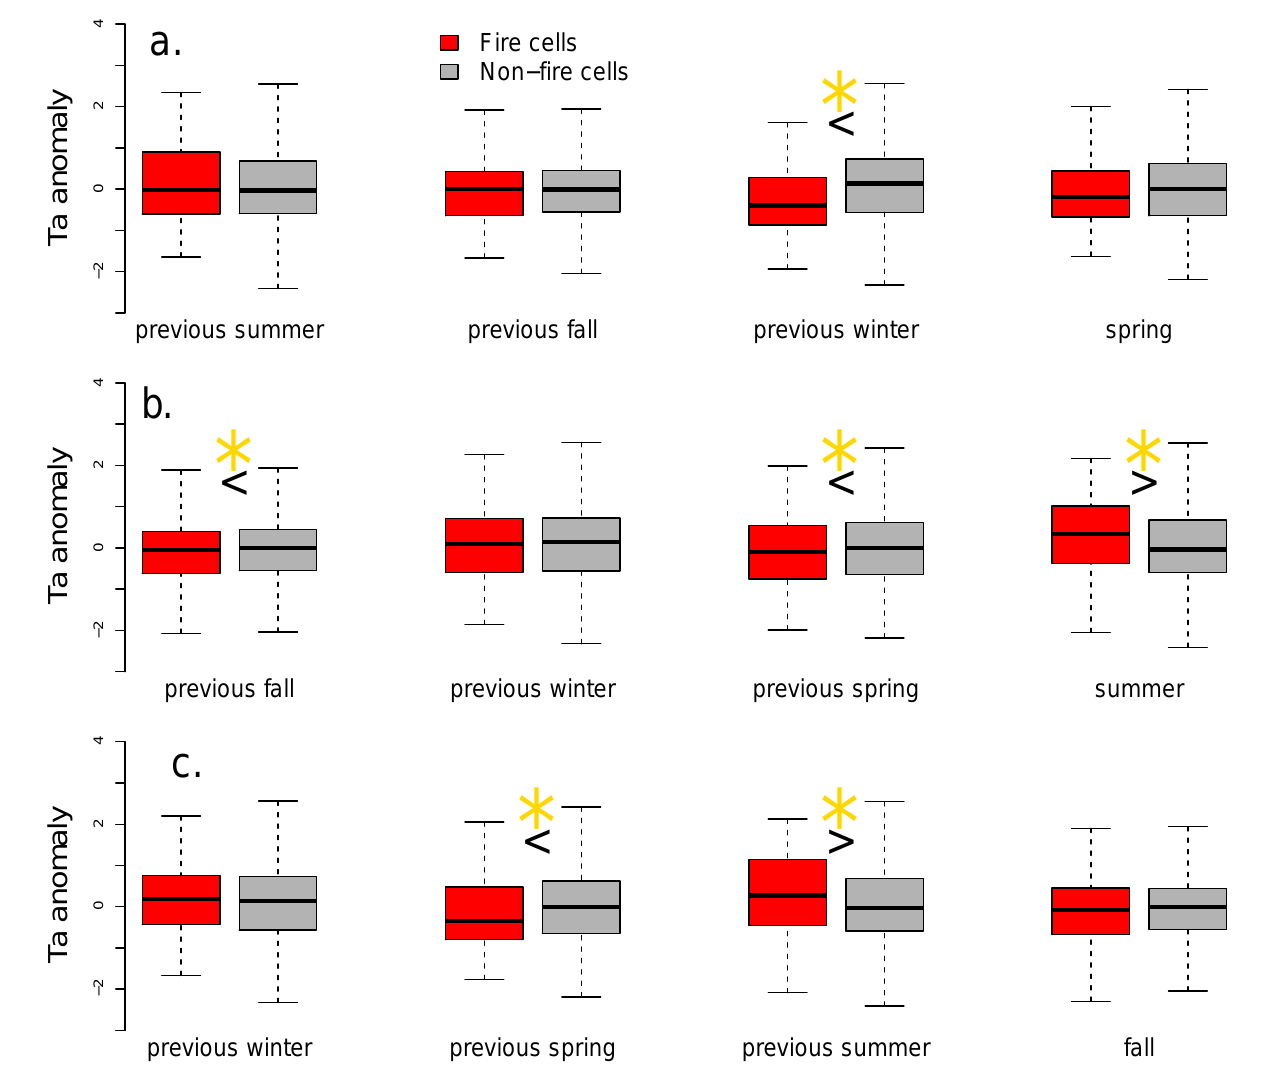
Figure 4. Boxplots illustrating differences in the anomaly of high-air-temperature months (anomaly = observed − long-term mean/standard deviation of long-term mean) between ignition (red) and non-ignition (gray) locations in the 3 seasons previous to and including the spring (Panel a ), summer (Panel b ), and fall (Panel c ) fire seasons. Significant differences and the direction of difference are indicated for each boxplot pair (one-tailed t -tests; p <